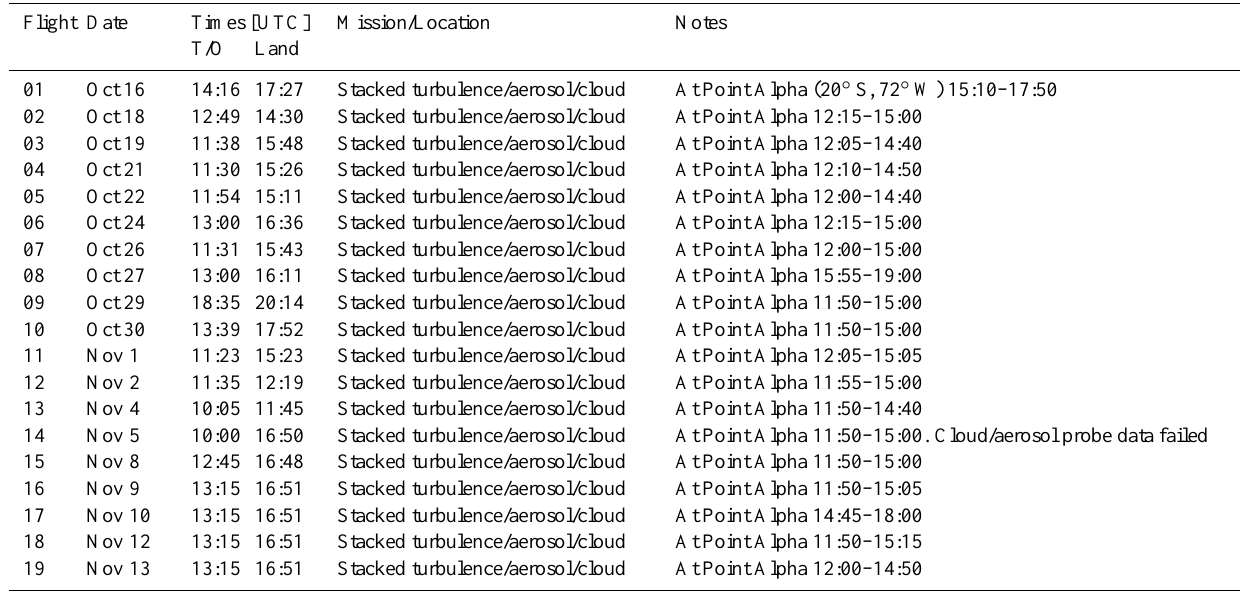
Table 10. Details of Twin Otter aircraft missions conducted in the VOCALS Regional